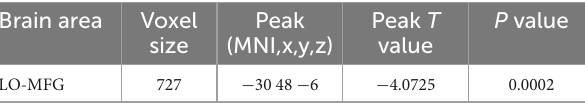
TABLE 2 Significantly different regions in ReHo between LDH-pre patients and